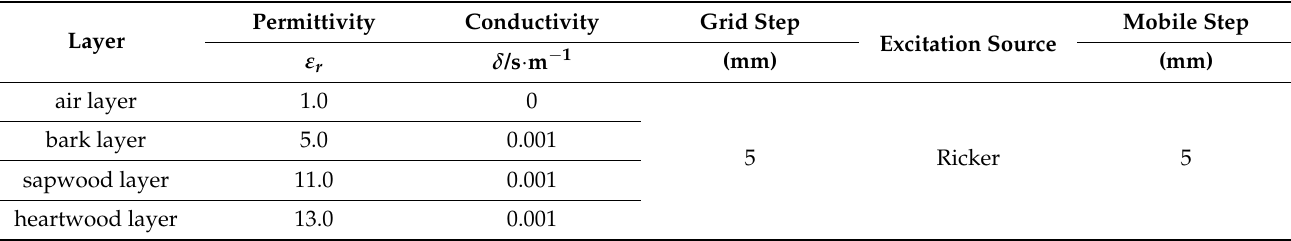
Figure 6. Forward simulation of structural parameters: ( a ) layered structure of the trunk; ( b ) radar image of the target. Table 1. Property parameters of chosen media in